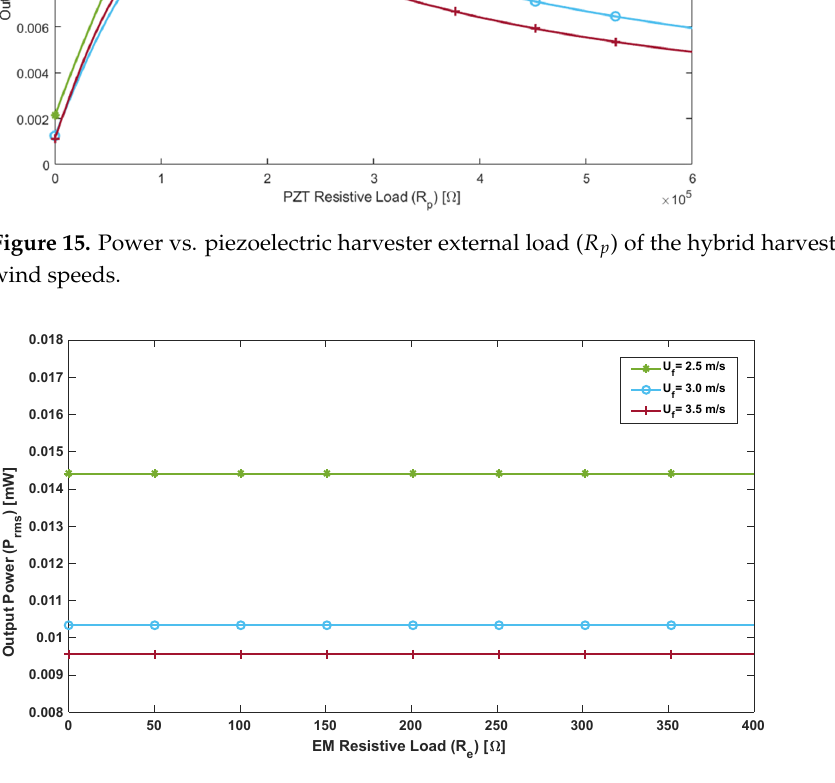
Figure 16. Power vs. electromagnetic harvester external load ( R e ) of the hybrid harvester at different wind speeds.